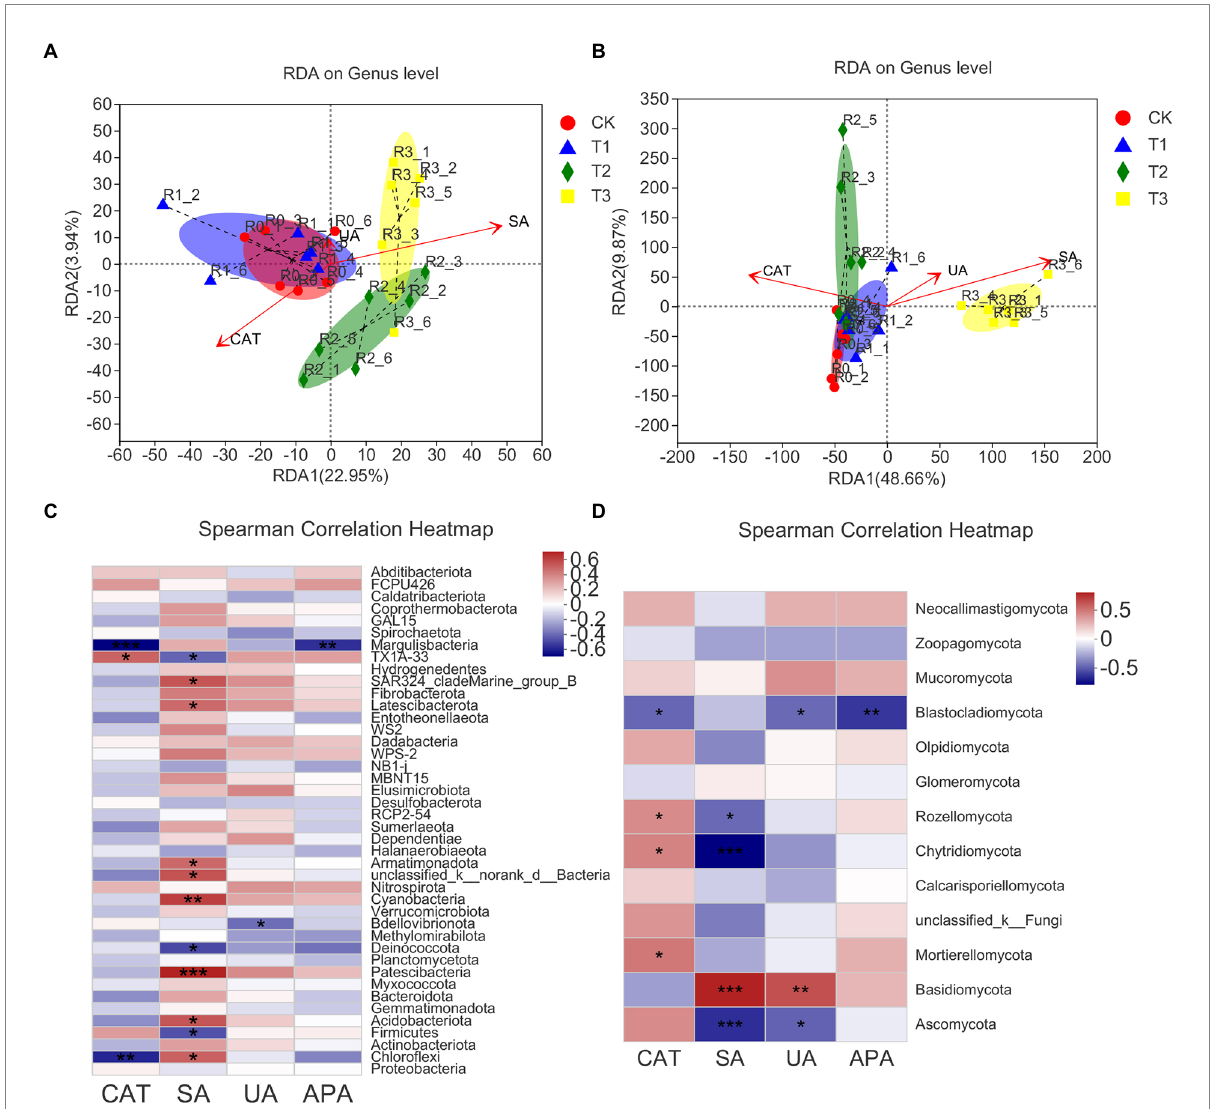
FIGURE 7 The ranking method developed by redundancy analysis and correspondence analysis (RDA/CCA) in different treatments. The environmental factor adopts the mean value of soil enzyme activity, including bacteria (A) and fungi (B) , at the genus level. The relationships and correlations between different phyla in bacteria (C) and fungi (D) with soil enzyme activities. n = 6, different stars indicate significant differences ( * p < 0.05; ** p < 0.01; *** p <